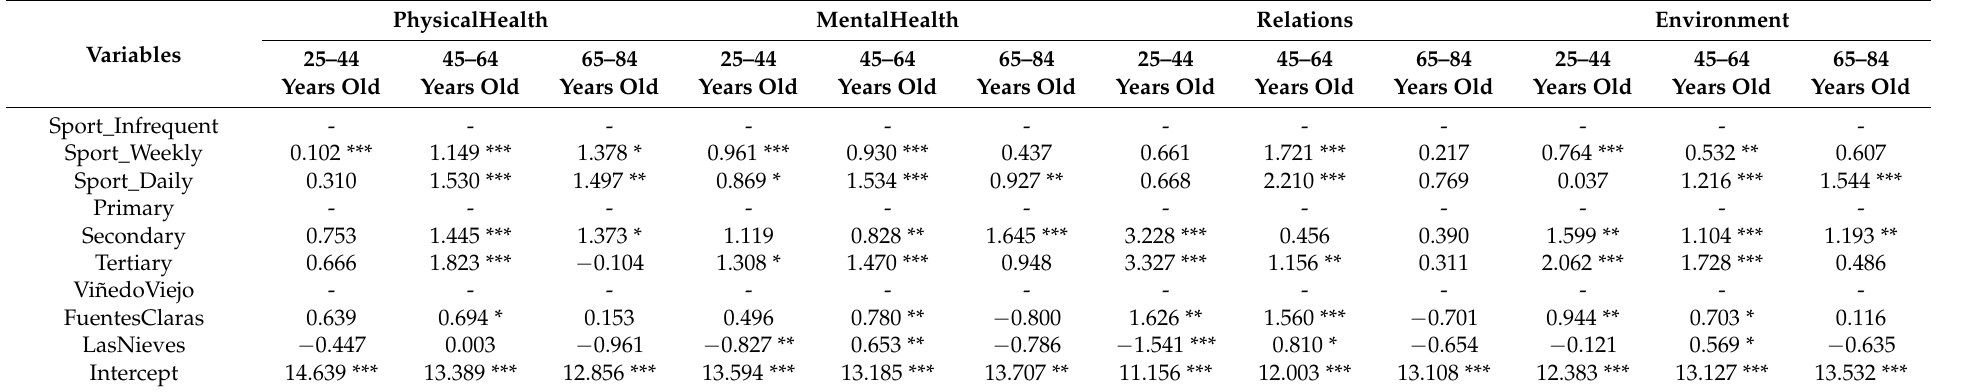
Table 5. Regression coefficients of health socio-economic determinants for men living in Casablanca ( n = 506).